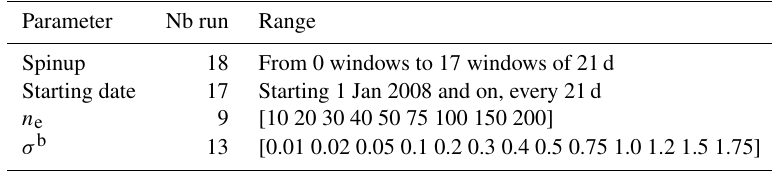
Table 1. Tested data assimilation parameters in the sensitivity tests.